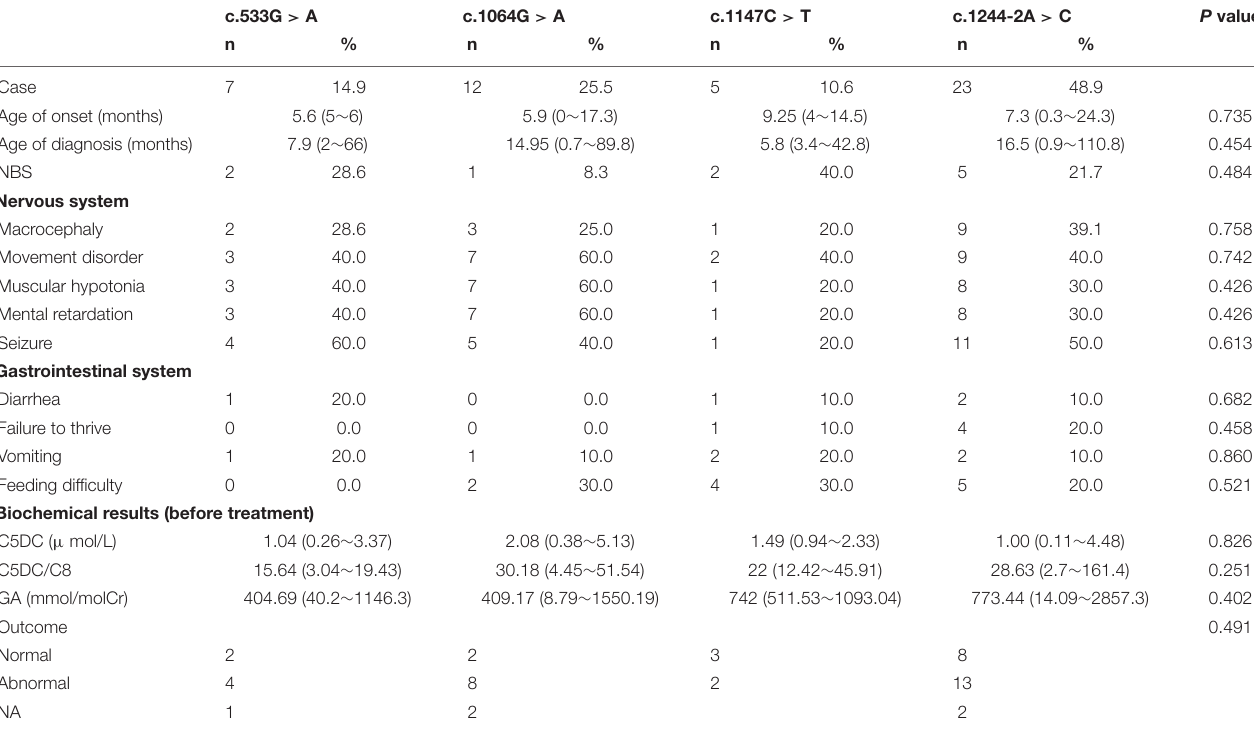
TABLE 4 | Correlation between genotype and phenotype in GA1 patients: comparison of the four most common variants from 47